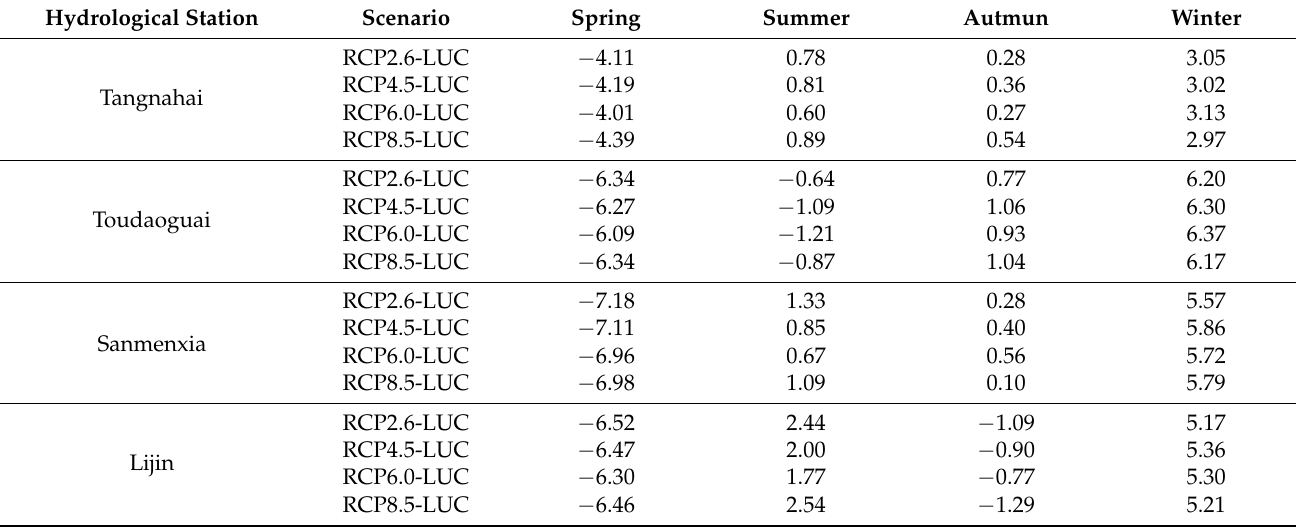
Table 7. The differences between the seasonal runoff proportion in the future period and the base period of the four hydrological stations (%).